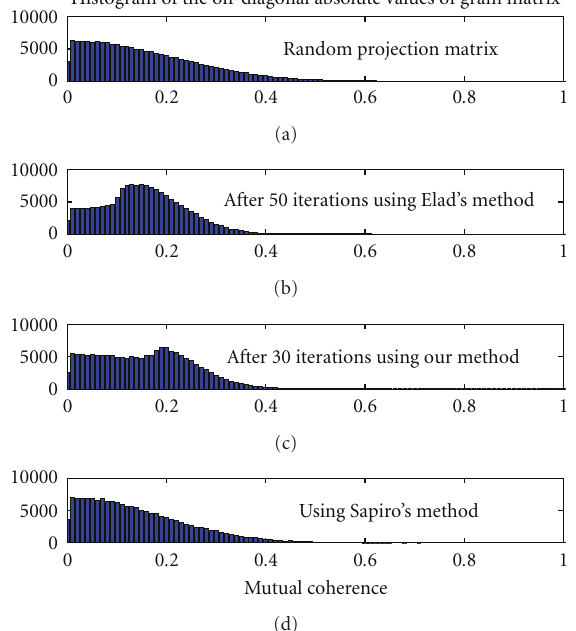
Figure 1: Histogram of o ff -diagonal absolute values of G before and after optimization.